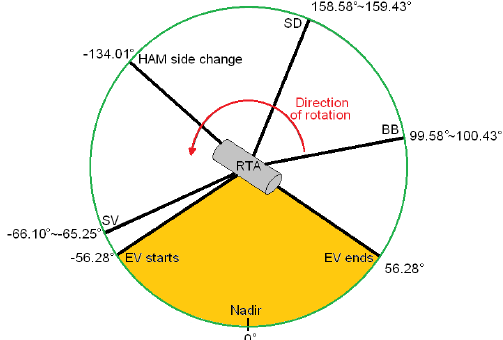
Figure 3. A simplified schematic of VIIRS view versus scan angle [2].